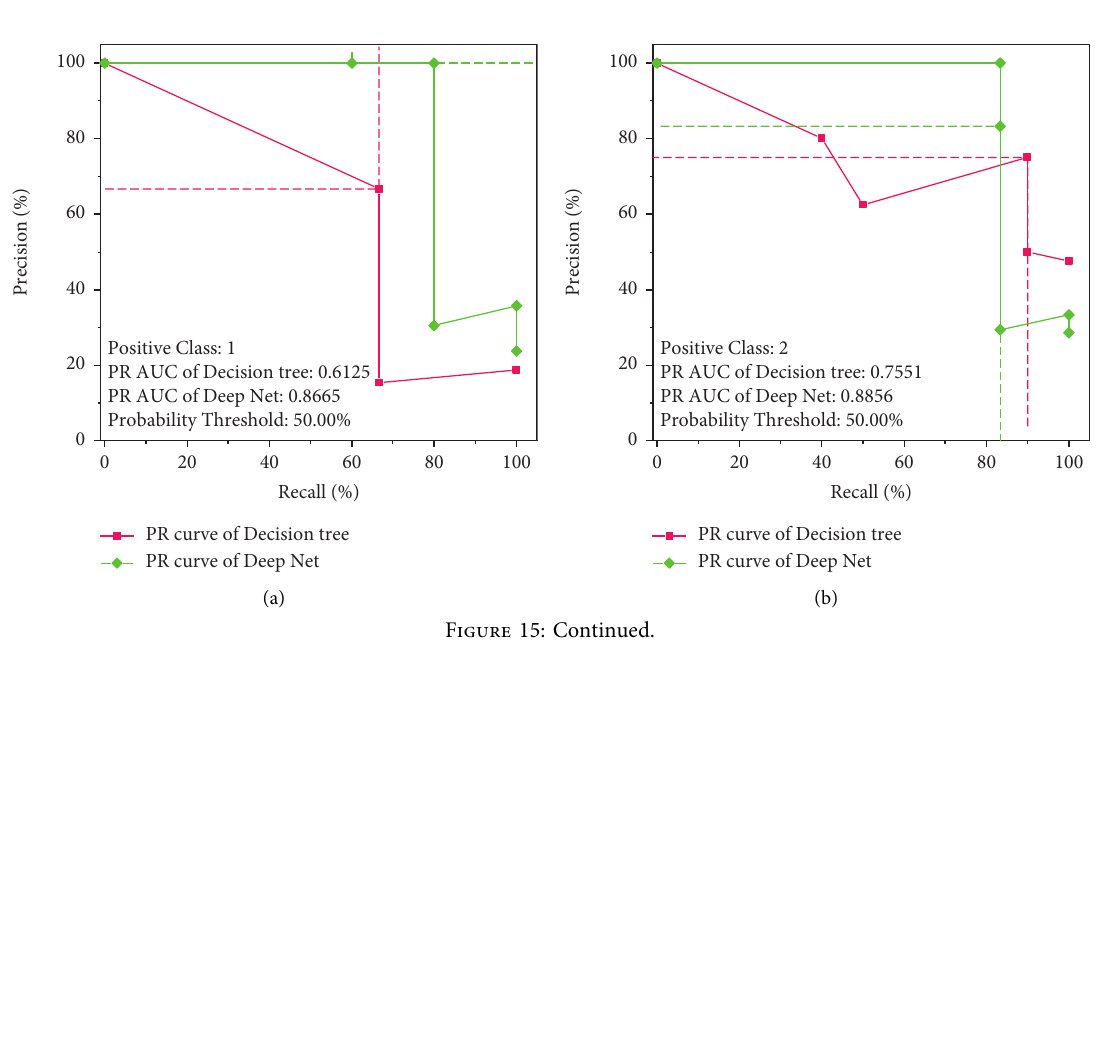
Positive Class: 2 PR AUC of Decision tree: 0.7551 PR AUC of Deep Net: 0.8856 Probability Threshold: 50.00%